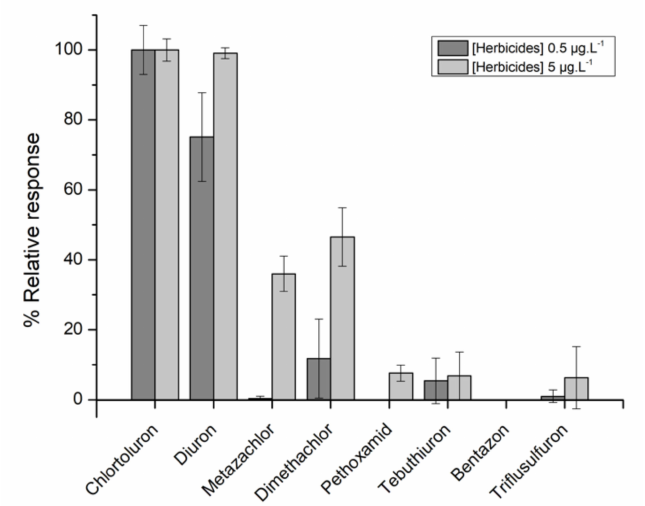
Figure 6. Relative response obtained in the presence of several herbicides compared to chlortoluron at concentrations of 0.5 and 5 µ g · L − 1